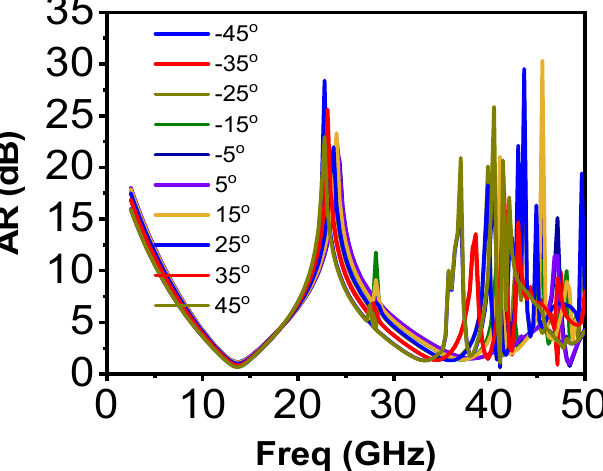
Figure 2. Simulated transmission response for the proposed metasurface with incident horizontal (x)polarized wave: ( a ) transmission component; ( b ) phase difference; ( c ) axial ratio. Simulated transmission response with incident vertical (y)polarized wave: ( d ) transmission components; ( e ) phase difference; ( f ) axial ratio (AR).